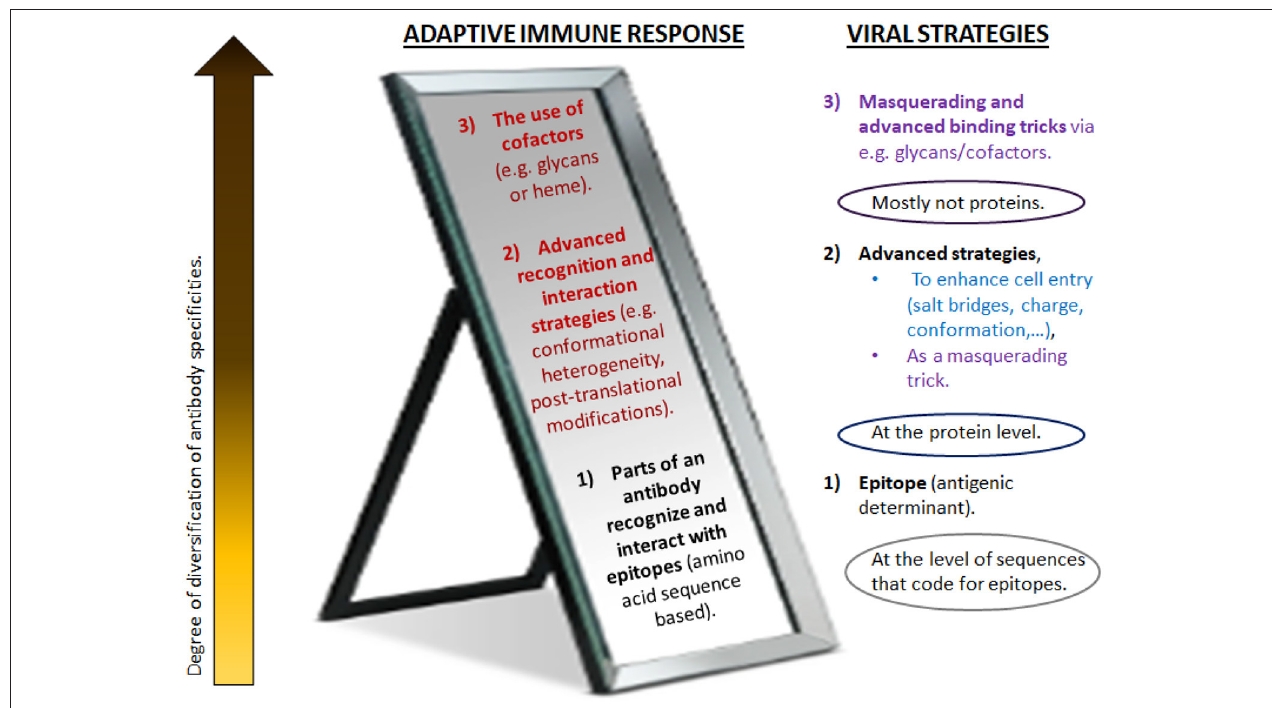
FIGURE 1 | Different levels of antibody diversification counteract (or mirror) various masquerading tricks of pathogens. Traditionally, adaptive immunity has focused on genetic mechanisms that give rise to the diversity of antibody V regions. These take place during B cell development in the bone marrow and upon encounter of antigen in the periphery. For increased specificity, refined receptors are acquired through somatic mutations and irreversible genetic recombination of antigen receptor segments. In contrast to more traditional vaccines, synthetic vaccines utilize short amino acid sequences of the immunogenic protein (epitopes) to evoke the anticipated antibody response. As this approach distinctively relies on the specific amino acid sequence of the immunogenic protein of interest, this is believed to induce a direct and potent immune response. However, the immune system has a much greater level of adaptability and plasticity than usually considered (here, depicted as higher levels). It mirrors various advanced masquerading tricks of pathogens (right) and goes far beyond what is encoded in the genome or generated by the acquisition of somatic mutations. Likely, the immune response is highly variable and interlinked, in order to simultaneously employ the most optimal strategies to combat the viral strategies ( Figure 4 ). Advanced strategies beyond the main receptor binding paradigm as suggested in Sørensen et al. (2020) for SARS-CoV-2 are depicted in blue; the strategies employed for coronaviruses in general are in purple. Red/dark red: frequently neglected strategies for remodeling V regions, as suggested to be a key factor in Covid-19. Many of these seem to be influenced by metabolism and the pathophysiologic state of host. (For details, see